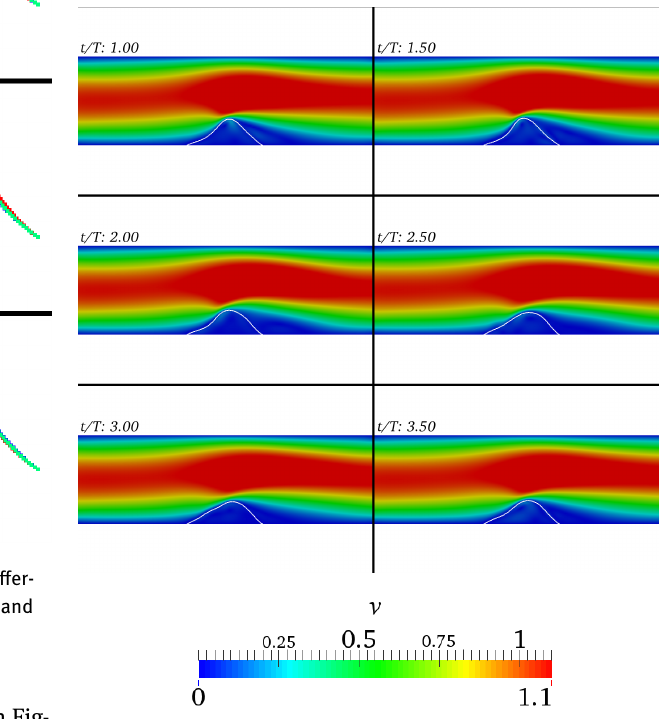
Figure 6: E = 4 and R = 100 . Velocity field at different time instants (normalized with respect to V